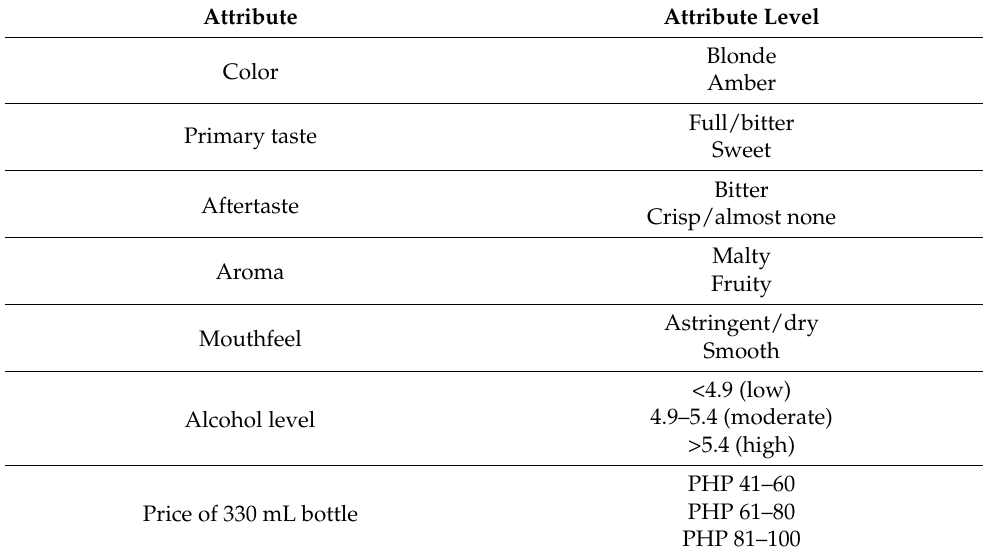
Table 1. Attributes of Philippine